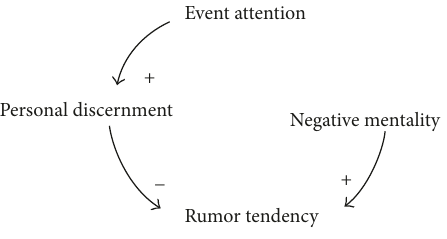
Figure 1: The personal factors causality diagram.